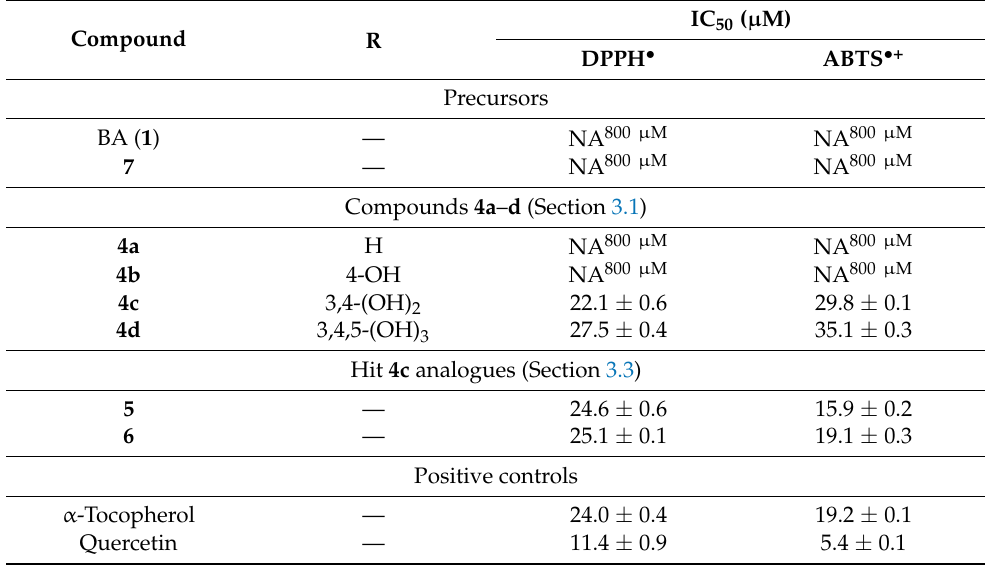
Scavenging activity of the tested compounds against DPPH • and ABTS • + (IC 50 , mean ± SEM).